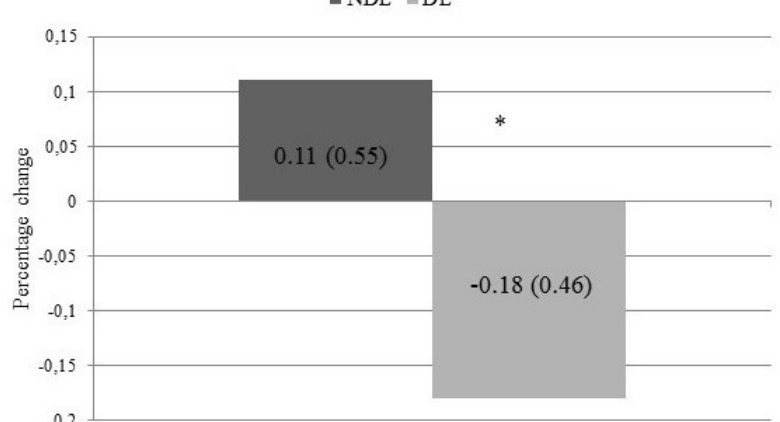
Figure 1. Absolute change in glycated hemoglobin (HbA 1c ) between baseline and follow-up visit in No-downloader (NDL) and Downloader (DL). Values are expressed as mean (SD).